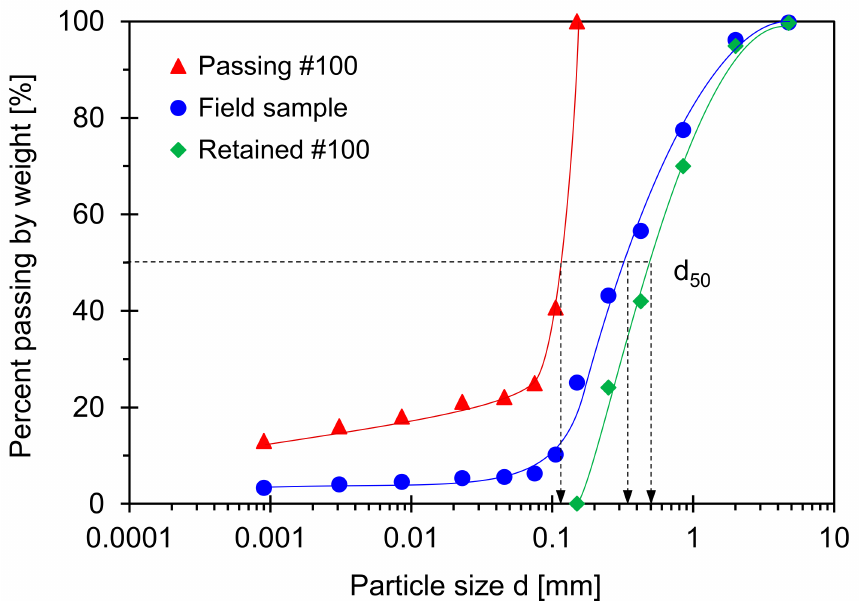
Figure 6. Particle size distribution of Savannah River sand (boring number: HPC-1, Sampling depth: 19.20 m–19.35